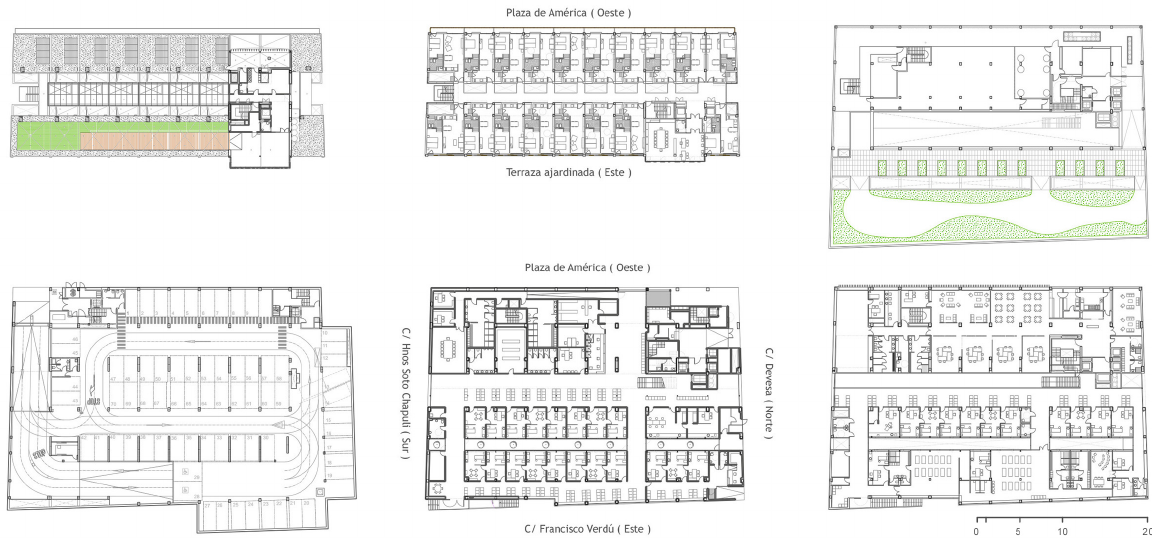
Figure 11. Plaza de Am é rica building: floor plans. Clockwise from upper left corner: seventh floor (sun deck and